Question: Sum up the contents of this chart in one sentence.
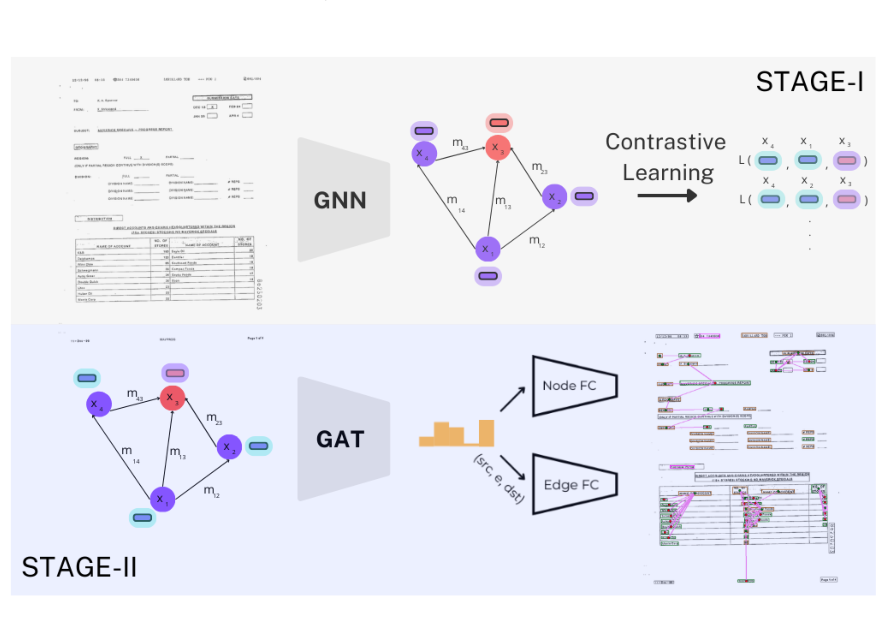
Answer: Overall Architecture of the Proposed GeoContrastNet Frame- work.In Stage I, a GNN processes a document image represented as an at- tributed graph, learning key-value edge features in a contrastive setting using the triplet margin loss. Then, in Stage II, a GAT traverses these features to predict entity labels (nodes) and their relations (edges) as output.